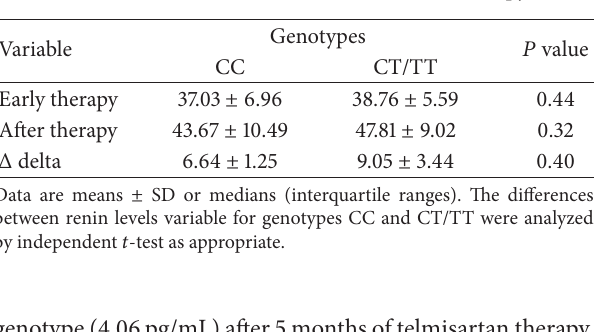
Table 3: Differences of renin levels (valsartan therapy). Genotypes 𝑃 Variable CC CT/TT Early